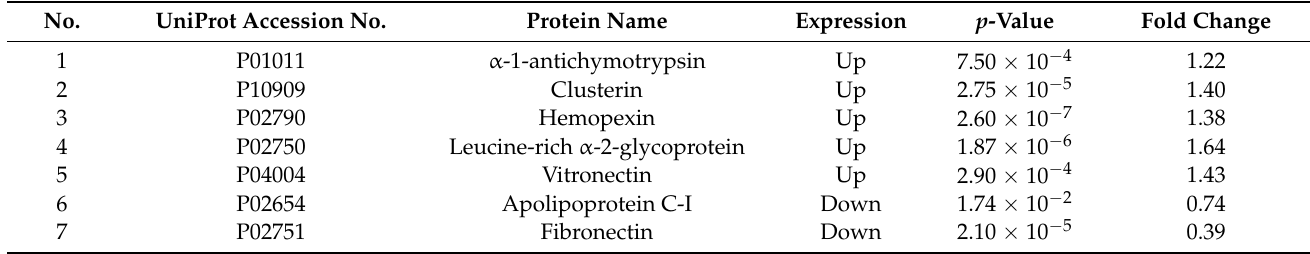
Table 1. List of protein candidates used for validation.